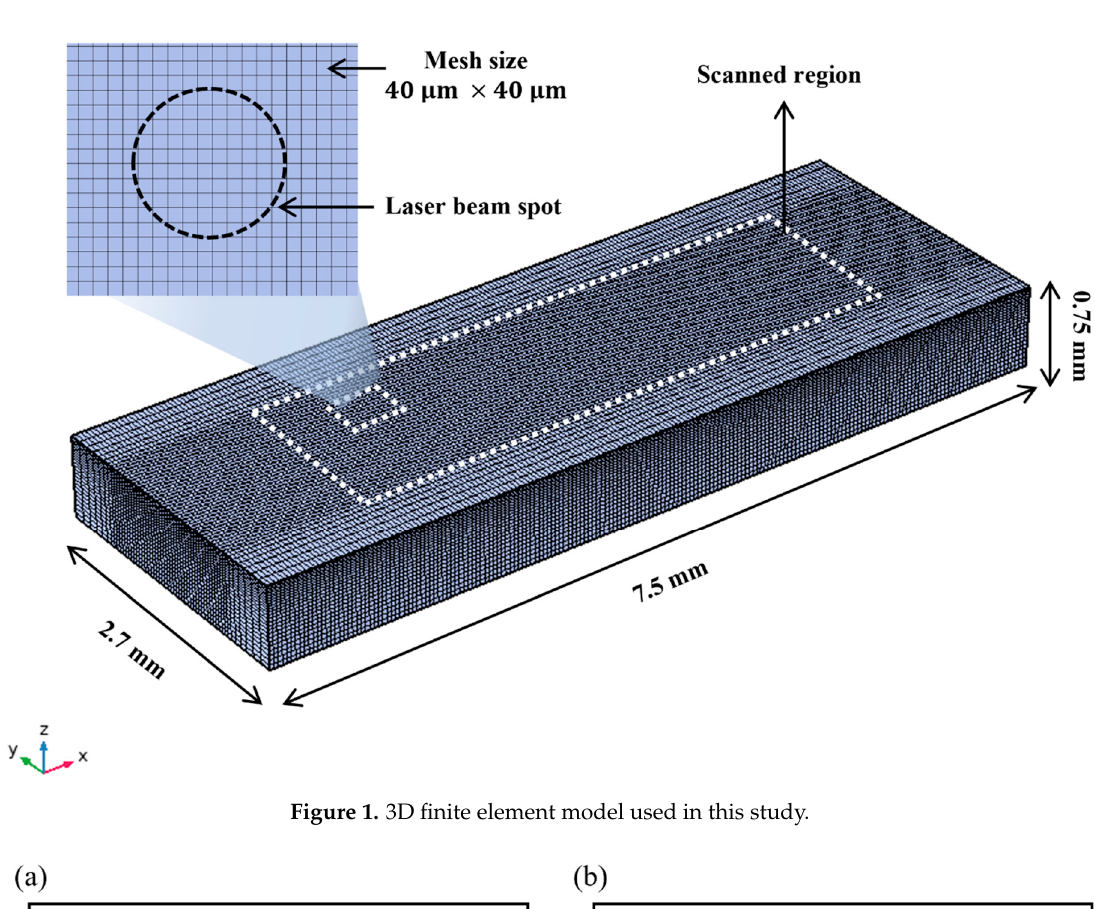
Figure 1. 3D finite element model used in this study.